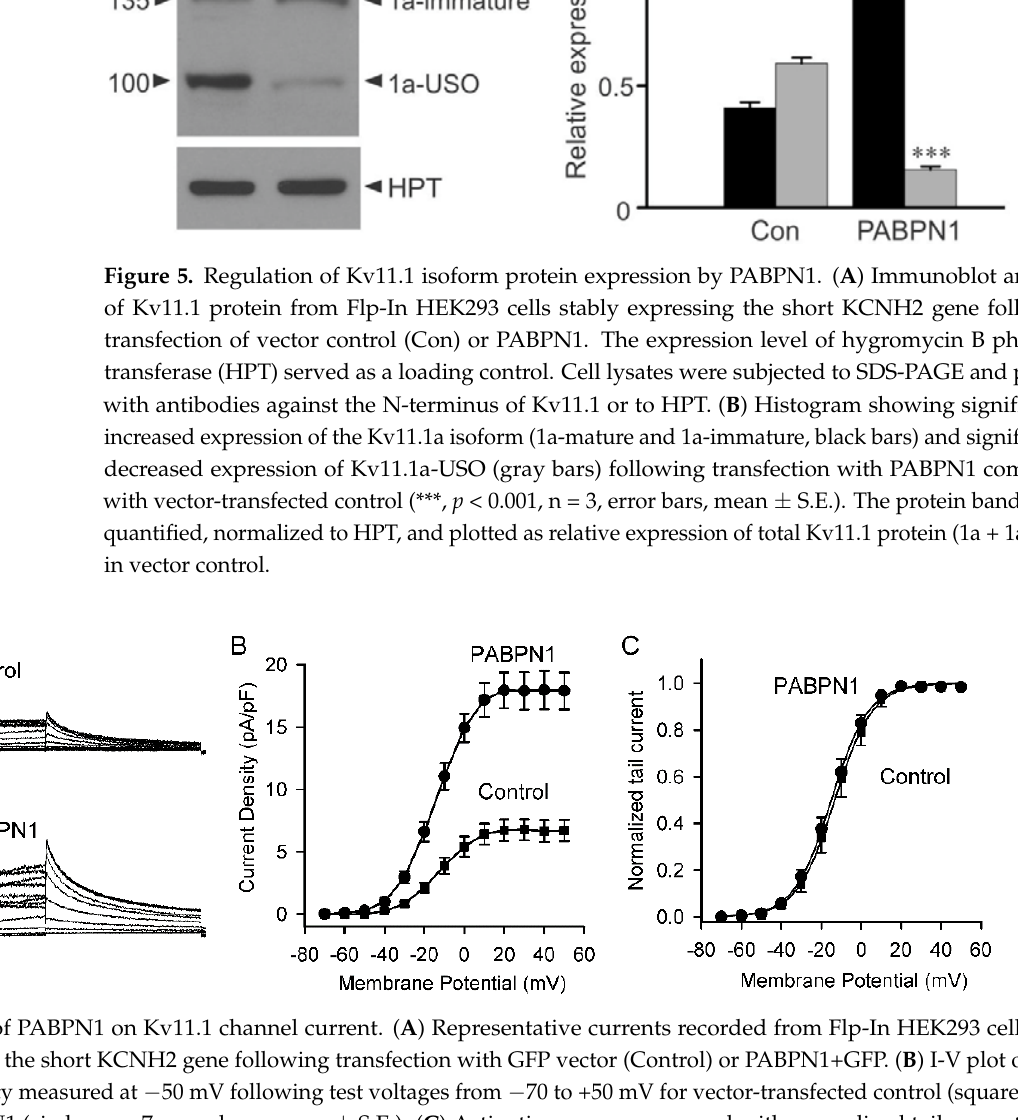
Figure 5. Regulation of Kv11.1 isoform protein expression by PABPN1. ( A ) Immunoblot analysis of Kv11.1 protein from Flp ‐ In HEK293 cells stably expressing the short KCNH2 gene following trans ‐ fection of vector control (Con) or PABPN1. The expression level of hygromycin B phosphotransfer ‐ ase (HPT) served as a loading control. Cell lysates were subjected to SDS ‐ PAGE and probed with antibodies against the N ‐ terminus of Kv11.1 or to HPT. ( B ) Histogram showing significantly in ‐ creased expression of the Kv11.1a isoform (1a ‐ mature and 1a ‐ immature, black bars) and signifi ‐ cantly decreased expression of Kv11.1a ‐ USO (gray bars) following transfection with PABPN1 com ‐ pared with vector ‐ transfected control (***, p < 0.001, n = 3, error bars, mean ± S.E.). The protein bands